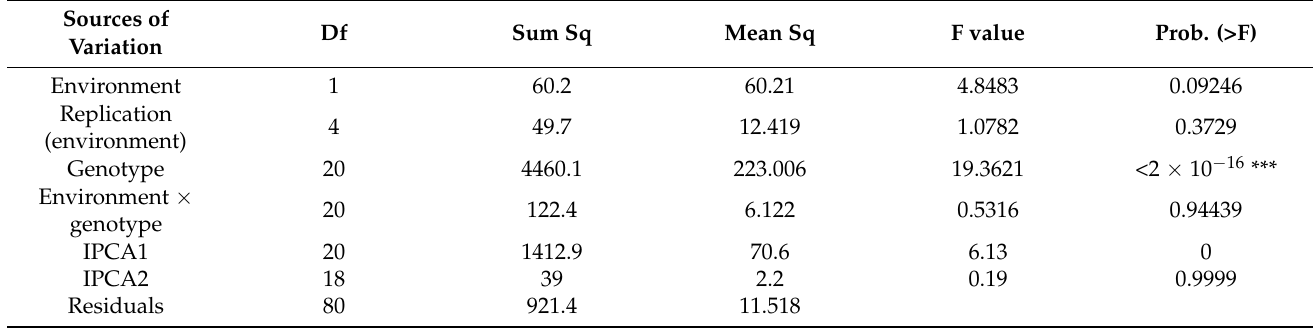
Table 2. AMMI ANOVA for potato yield (two years pooled data) over two environments.